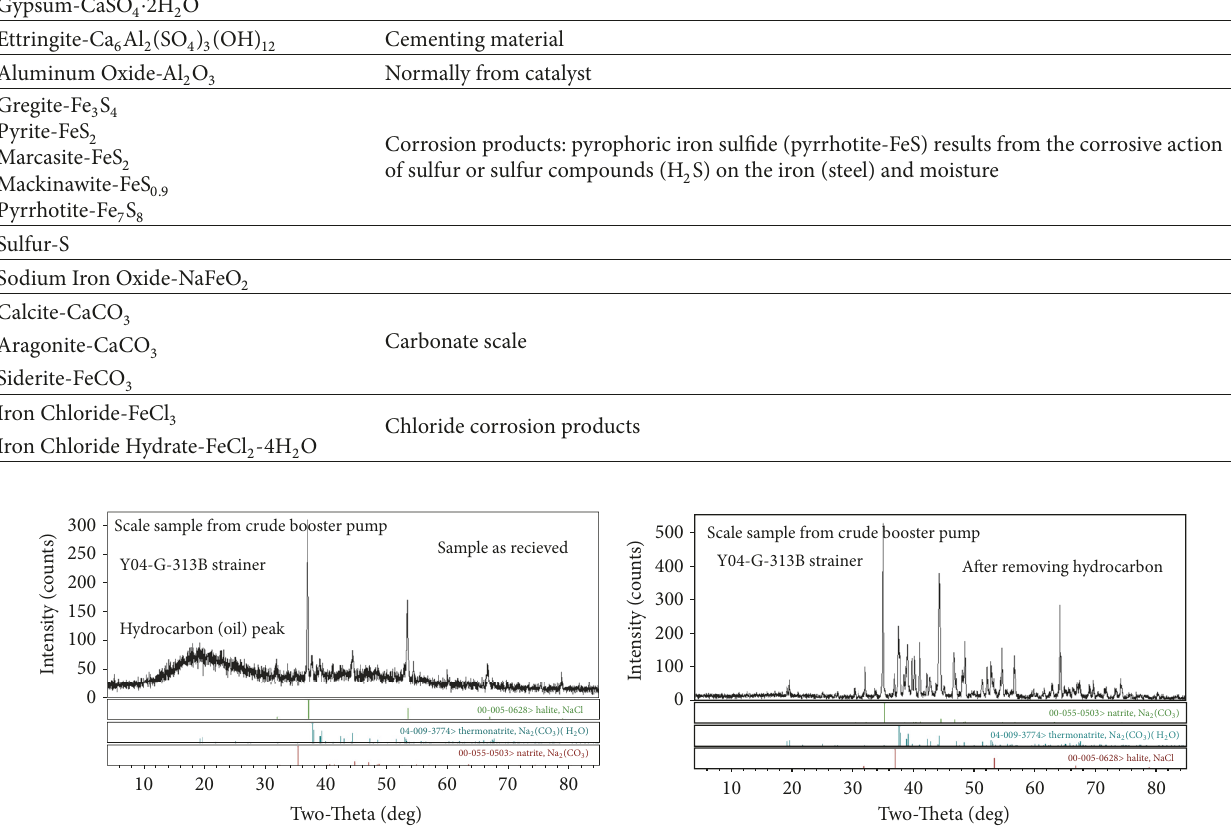
Figure 6: Phase identification results of the scale sample from crude booster pump: (a) the as-received and (b) after removing hydrocarbon along with the standard reference minerals for halite (NaCl), thermonatrite (Na 2 (CO 3 )H 2 O), and natrite (Na 2 (CO 3